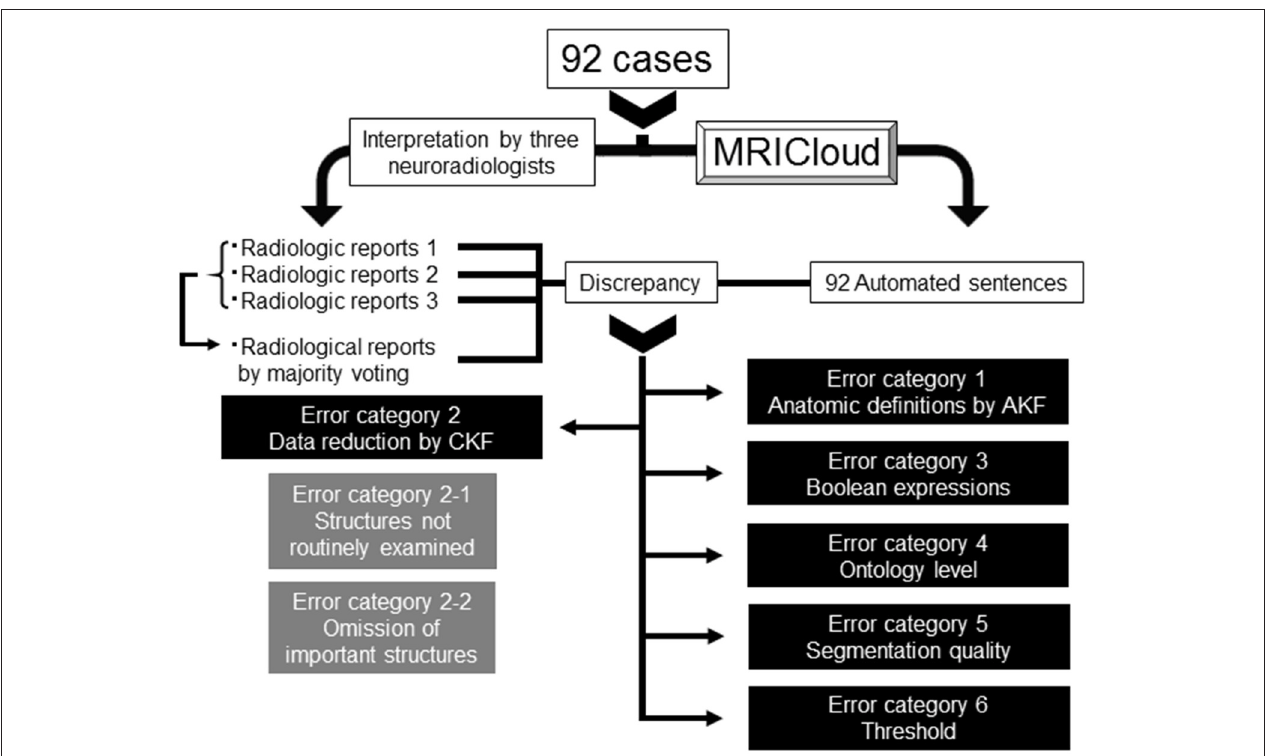
FIGURE 2 | Decision-making tree of the reasons for discrepancies between the radiologic reports and automated sentences. AKF, Anatomic Knowledge Filter; CKF, Clinical Knowledge Filter.